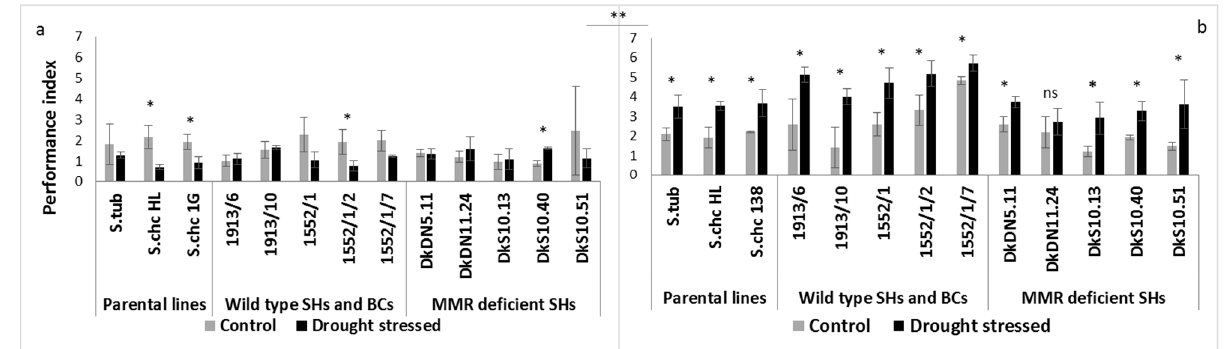
Figure 11. Photosynthesis performance index (PI) (mean ± SE, n = 3) of SHs, BC1 clones, and parental lines ( S. tuberosum and two accessions of S. chacoense — S.chc ) in control and drought conditions: ( a ) first fluorescence measurements at two weeks, ( b ) second measurements on six week old plants. ** indicates significant differences ( p < 0.001) in the total PI indexes of the first measurements compared to second measurements; *indicates significant differences ( p < 0.05) between control and drought stressed plants; ns means there was no significant differences ( p > 0.05) between control and stressed plants.